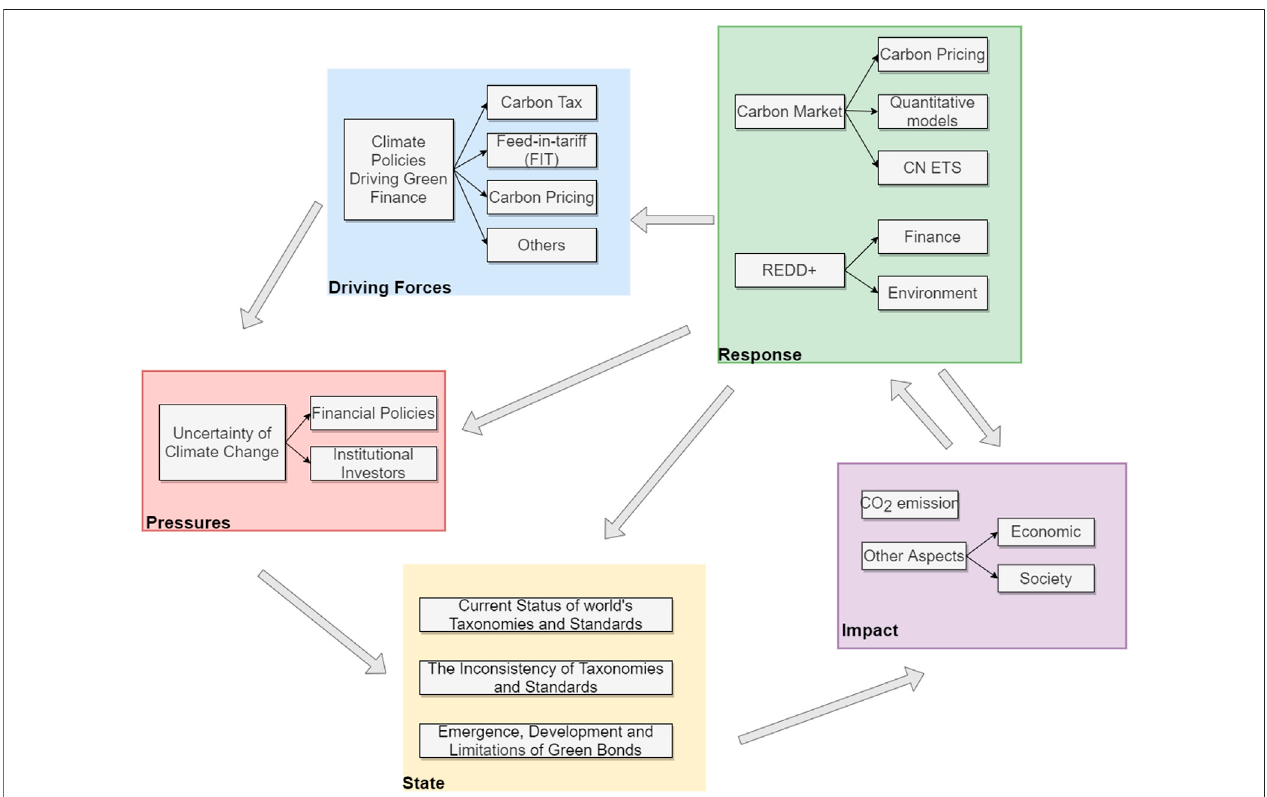
FIGURE 13 | Research topics of green fi nance and carbon emission reduction in DPSIR model.